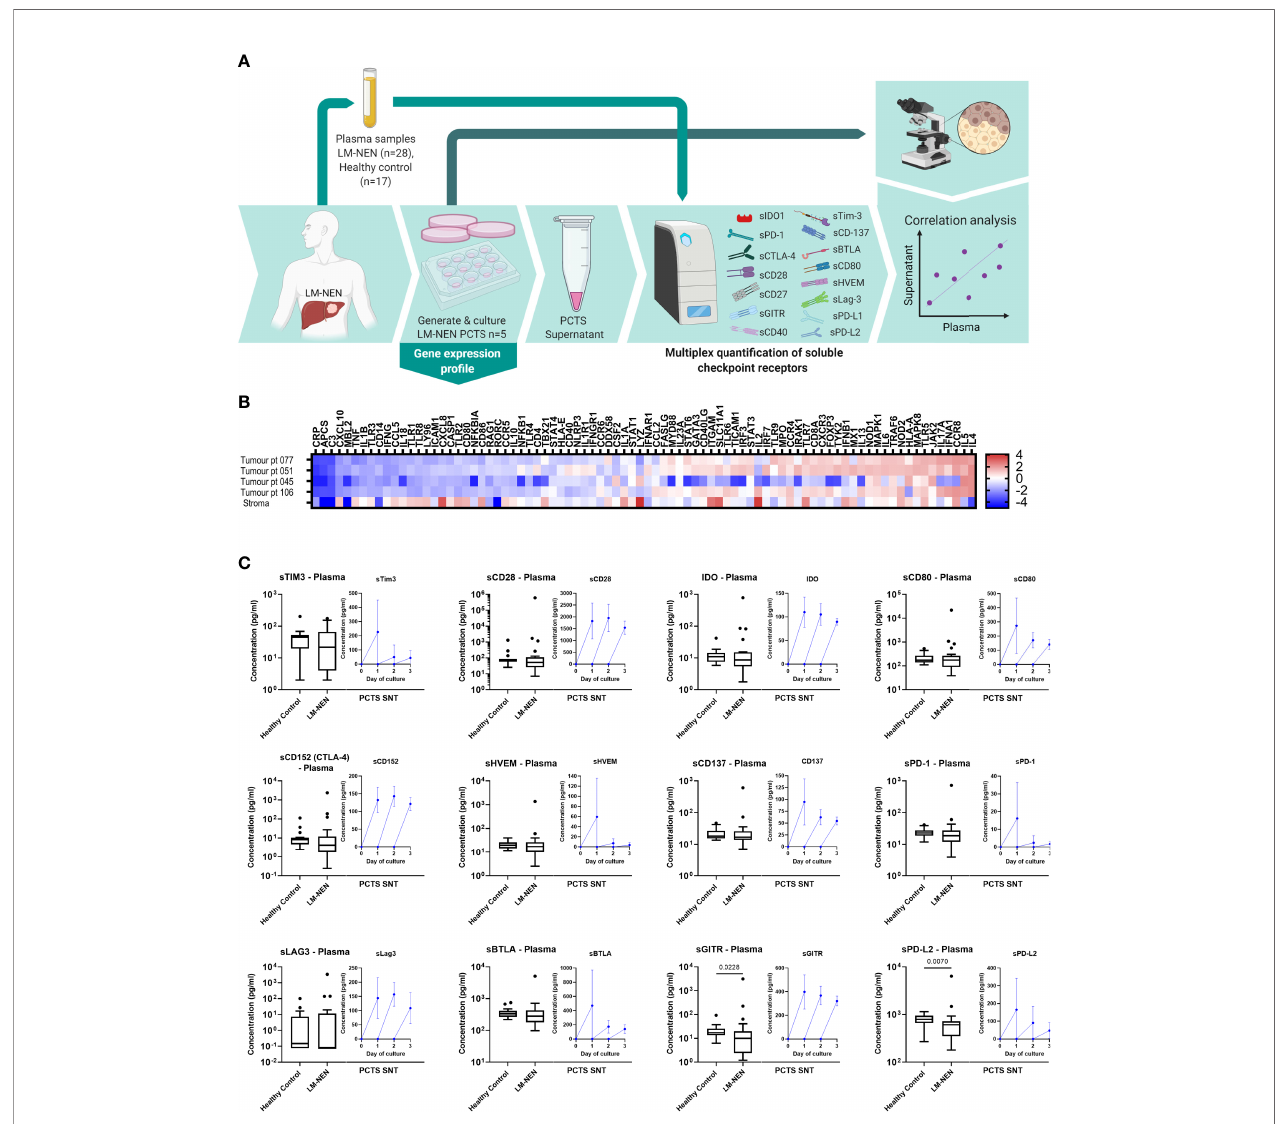
FIGURE 5 | LM-NEN PCTS retain innate and adaptive immunity markers and release soluble checkpoint receptors (solCRs) in the supernatant. (A) Schematic representation of the experimental design. Plasma samples were collected from LM-NEN patients (n=28) and healthy controls (n=17). Additionally, PCTS were generated from patients with LM-NEN (n=5) and culture supernatants collected at day 1, 2 and 3. solCRs were quanti fi ed in plasma and supernatants using Luminex. In parallel, gene expression analysis of innate and adaptive immunity markers was performed at day 1. Created with BioRender.com. (B) Heatmap showing the differential gene expression of immune cell markers in tumour versus surrounding tumour-free liver tissue in slices derived from patients with LM-NEN (n=4) and primary liver cancer with a prevalence of stroma, stroma (n=1). (C) Levels of solCRs in LM-NEN plasma (black box and whiskers plots) and slice supernatants at day 1, 2 and 3 (blue line graphs, mean ± SD of 3 replicates per patient). The supernatant was refreshed daily hence the levels are always displayed from